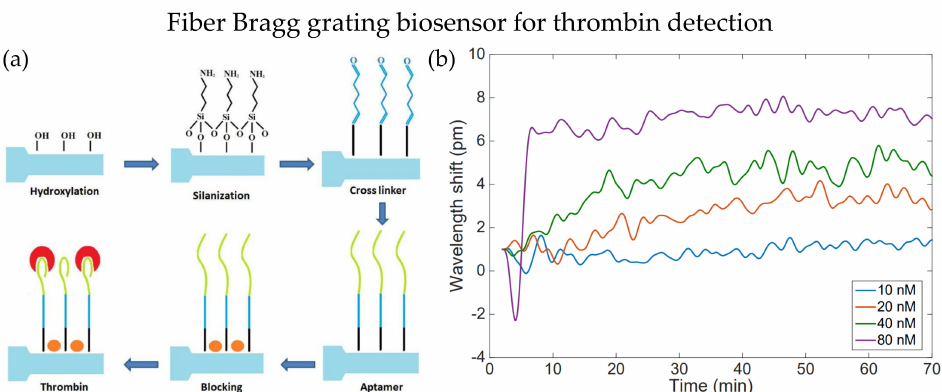
Figure 1. ( a ) Process of sensor probe preparation for thrombin detection. ( b ) Wavelength shift for detection of thrombin with different concentrations using EFBG, the results are observed for 70 min. Adapted with permission from Ref. [33]. Copyright 2018,